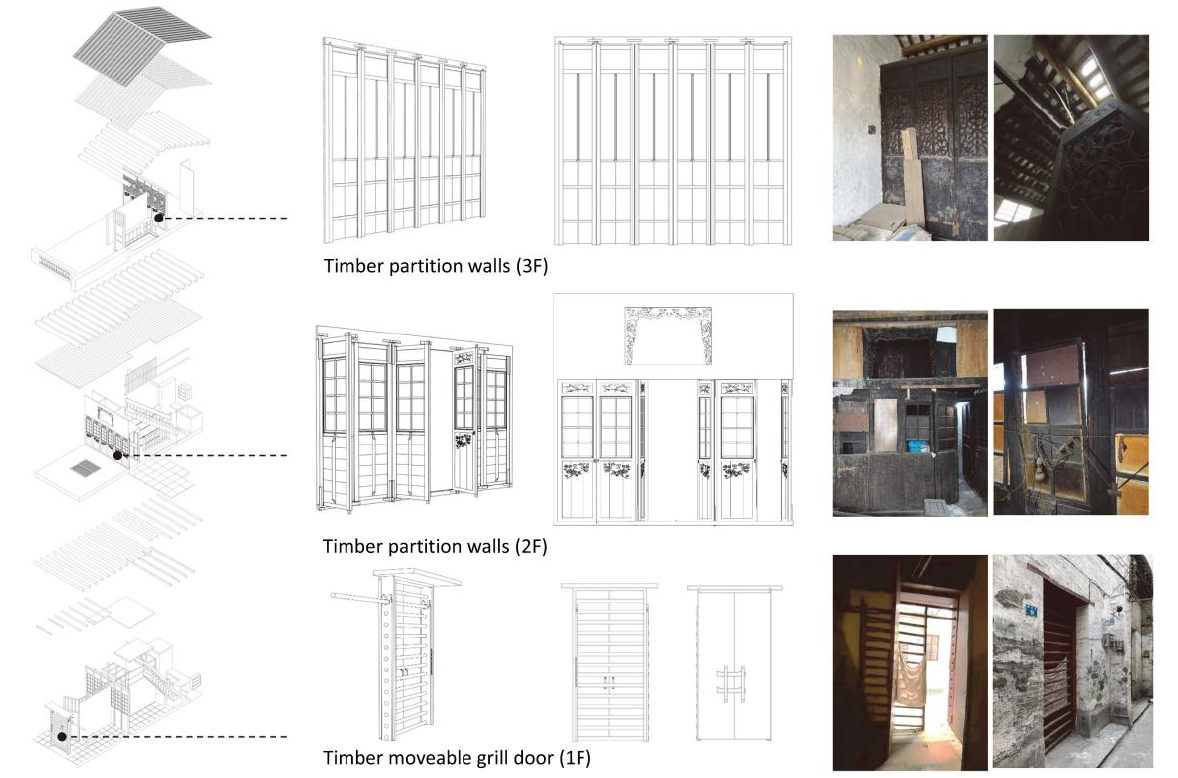
Figure 11. Observation of the construction response to the local climate (drawn by the students).